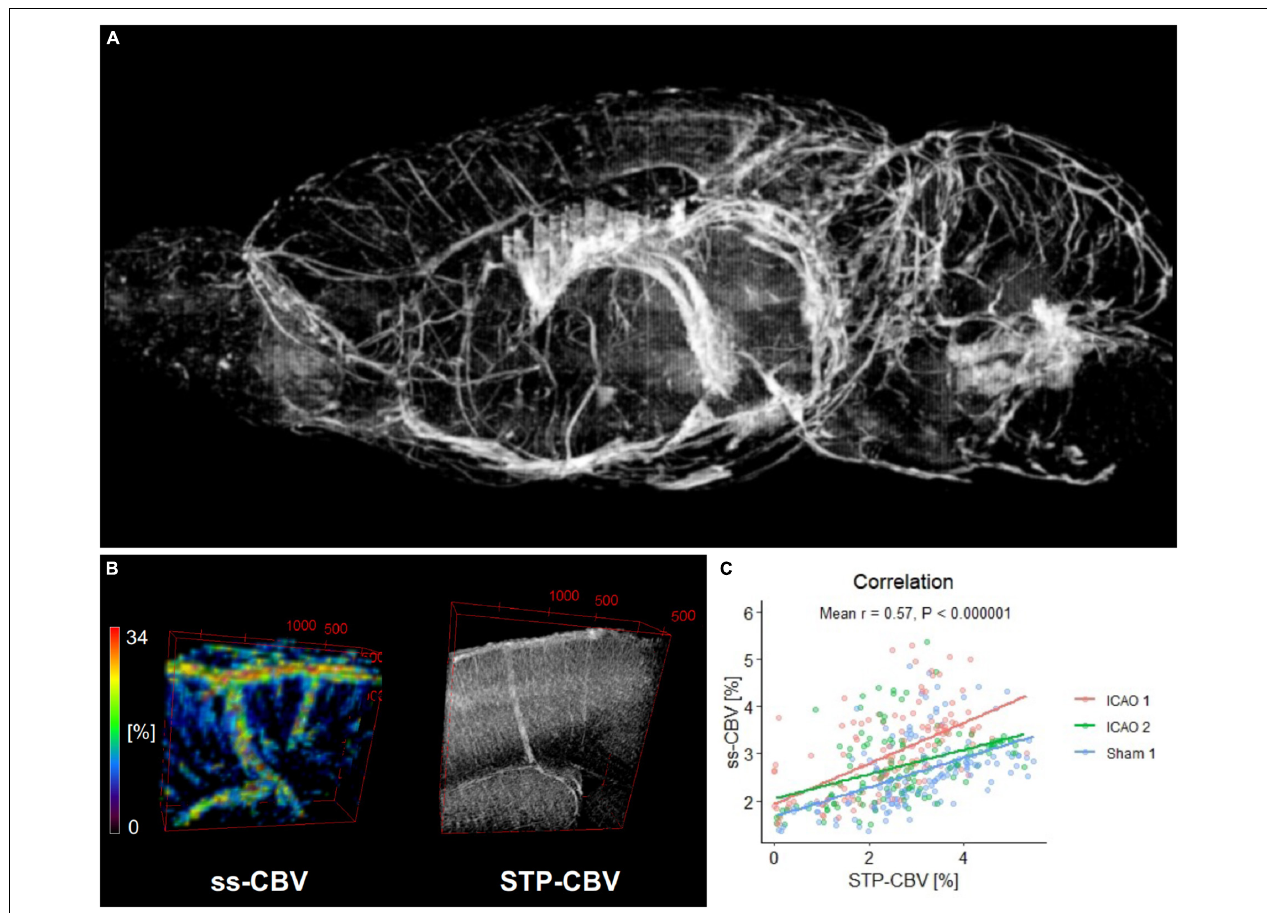
FIGURE 4 | Validation of ss-CBV against 3D serial two-photon tomography (STP). (A) Whole-brain histologic angiography: Perfused blood vessels were stained in vivo with lectin from Lycopersicon esculentum and measured by STP. The image shows a 3D reconstruction of large- and medium-size blood vessels of the cerebral vascular tree using the ImageJ plugin Volume Viewer (arbitrary units). (B) Panel shows corresponding maps of iron oxide nanoparticle-based ss-CBV and STP-CBV (including the capillary bed) reconstructed from STP (unit: volume percent). (C) Positive and significant correlation between STP-CBV and ss-CBV among 406 brain regions defined by the Allen murine brain atlas in 3 mice described by the mean Spearman’s rank correlation